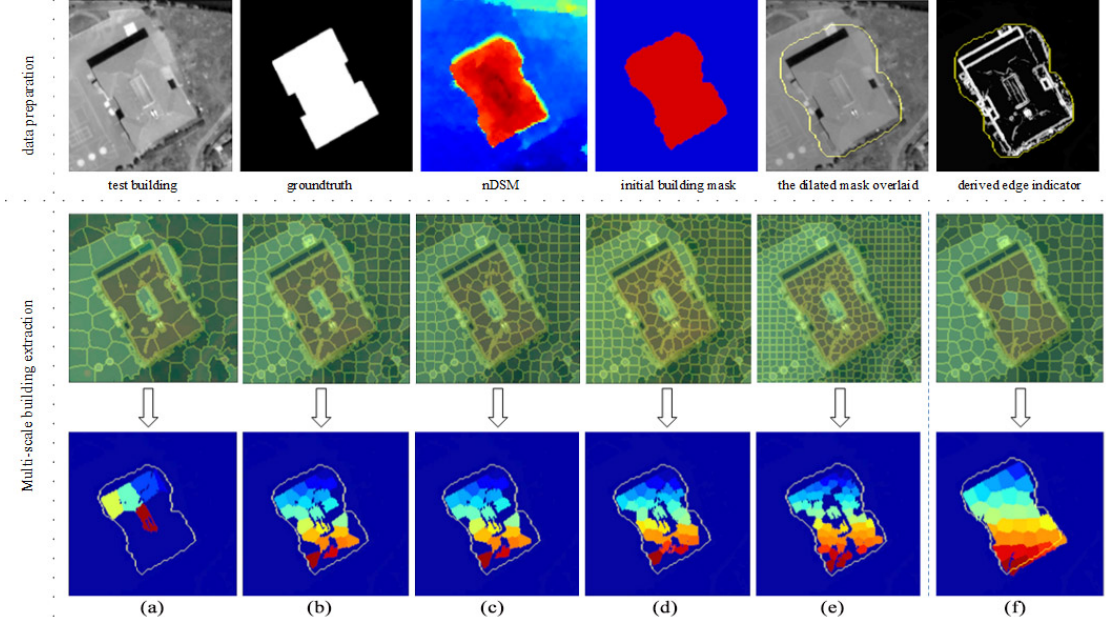
Figure 9. The first row shows the data preparation phase results for a test building. In the second row the mean-images generated from multi-scale ESLIC superpixels are shown. The last row illustrates how the most probable building parts are derived and kept from the initial rough masks; starting from bigger scale and larger superpixels to the smaller one ( a – e ), and how the integrated superpixel is overlaid on the mean-images on each scale ( f ). In the last row each color represents a